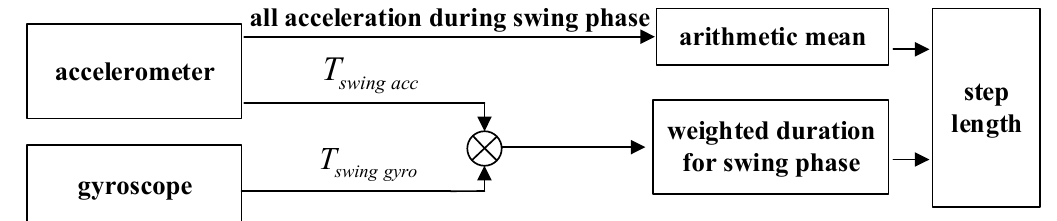
Figure 5. The flow chart of the proposed step length estimator.